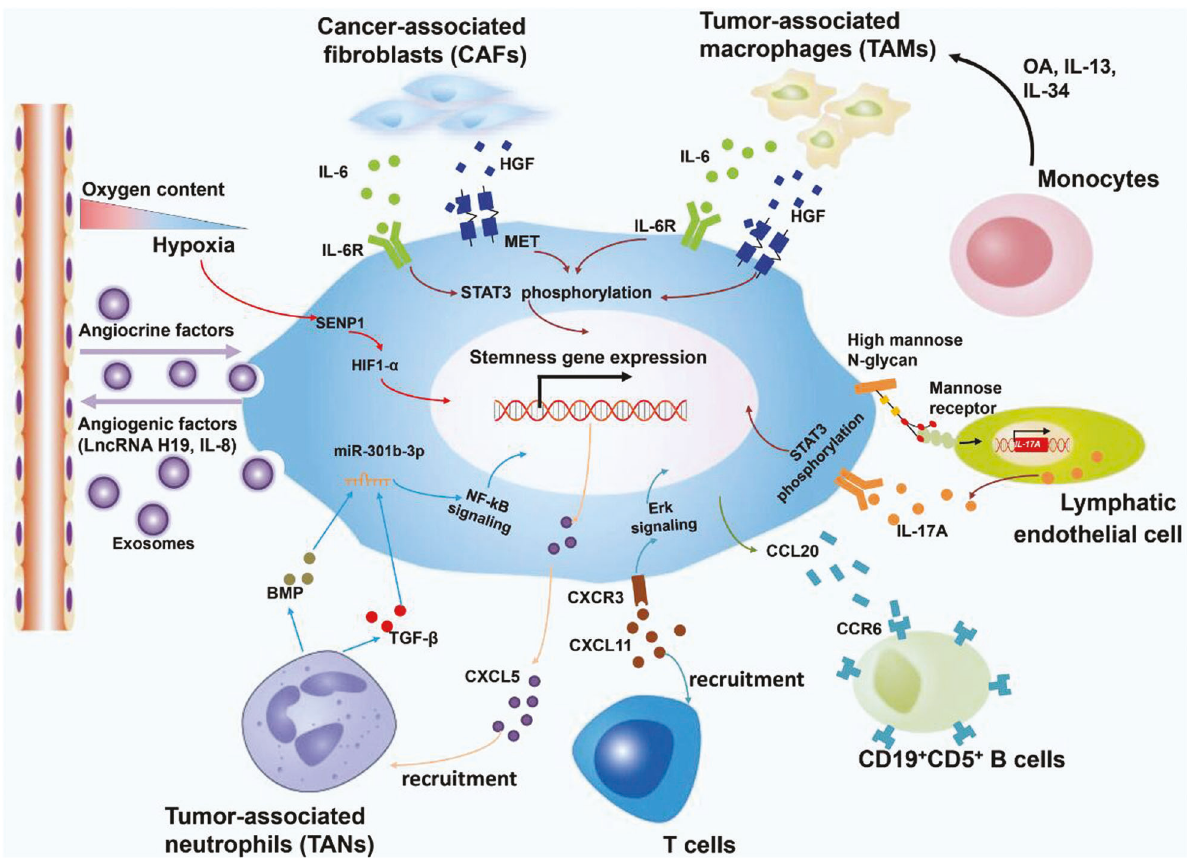
Fig. 7 The crosstalk between LCSCs and cellular components in the TME promotes stemness maintenance in HCC. Cellular components in the TME include tumor-associated macrophages, monocytes, fi broblasts, neutrophils, hepatic stellate cells, LECs, T cells, and B cells. Moreover, angiogenesis and the hypoxic microenvironment promote stem cell gene expression and tumorigenesis. OA